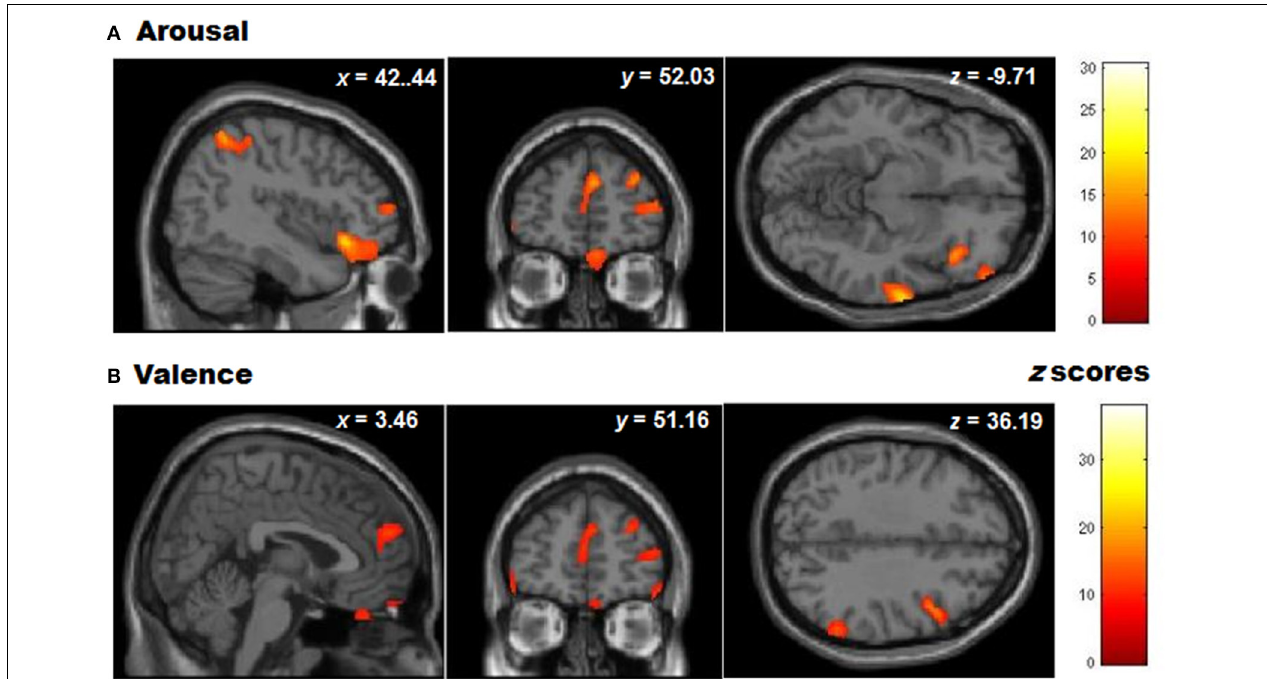
FIGURE 6 | Whole brain patterns of gray matter volumes correlated with task performance in controls. (A) Arousal rating differences and (B) Valence rating differences (presented at a level of p < 0 . 001 unc).